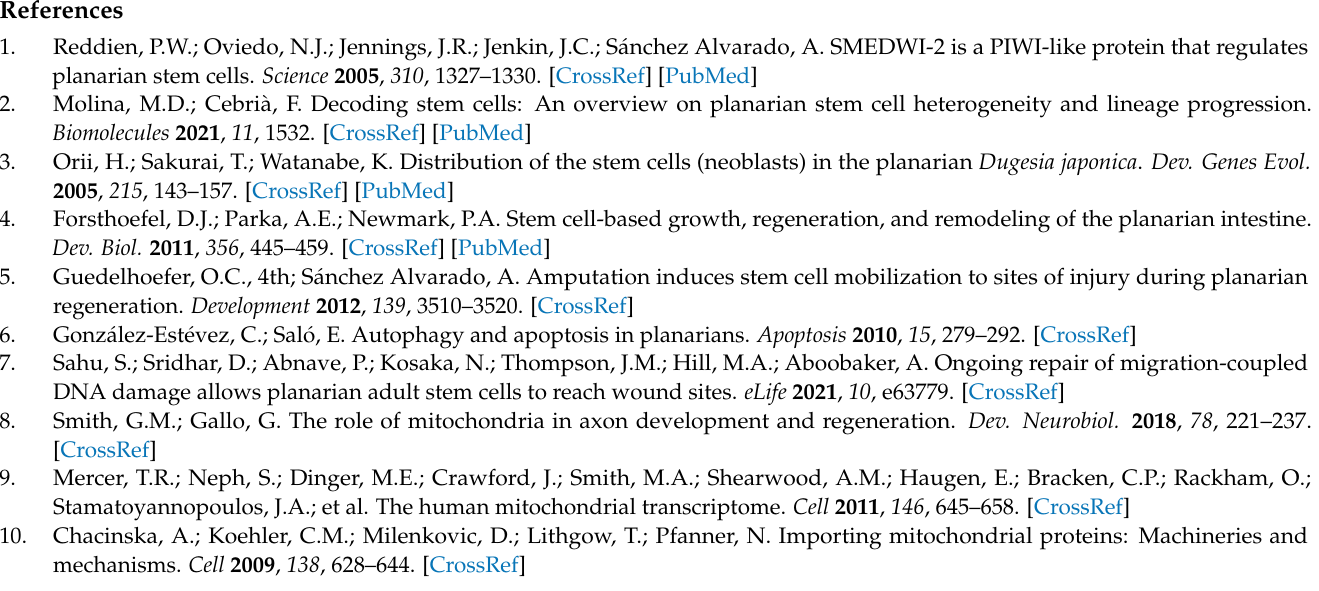
cytomorphological difference of head region between the control and RNAi revealed by HE staining. Figure S6: Morphological changes of intestinal tissues after RNAi revealed by HE staining. Figure S7: Neoblast-like cells in planarian revealed by TEM. Figure S8: Local location of neoblasts-like cells. Figure S9: Specificity of the commercial HSP60 antibody revealed by fluorescent-immunostaining and Western blot. Excel File S1: Primers used in this work. Excel File S2: Smedhsp60 expression